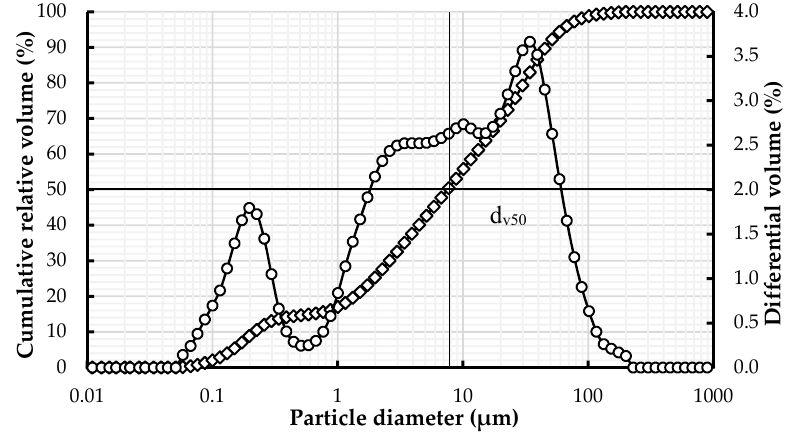
Figure 1. Earth particle size distribution and differential volume. Table 1. Chemical composition of the earth studied by X-ray fluorescence analysis. Values are given in mass %.